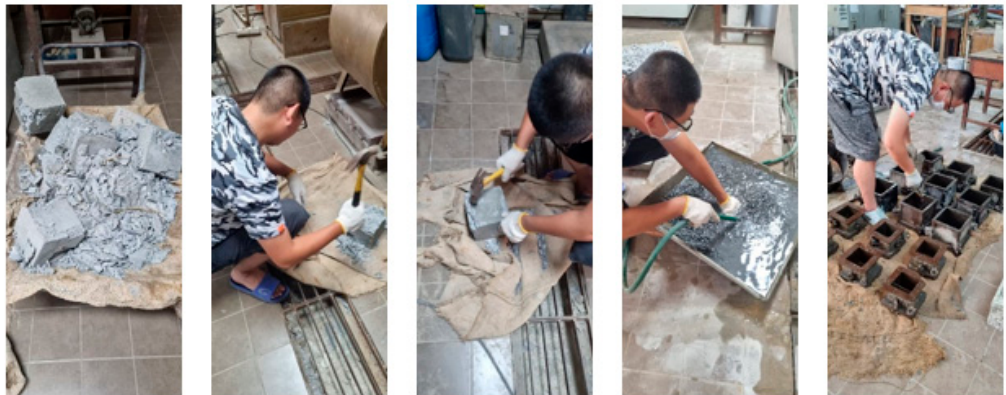
Infrastructures 2023 , 8 , 38 Figure 1. Acquisition of recycled aggregates in process. Figure 1. Acquisition of recycled aggregates in process.